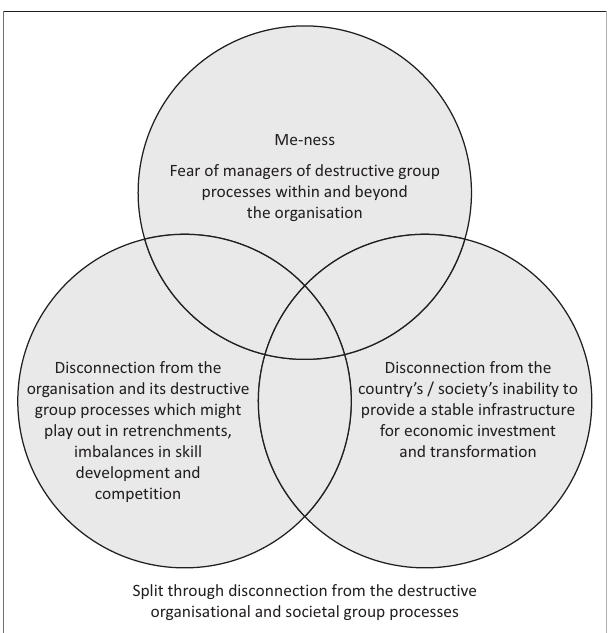
FIGURE 6: Me-ness.